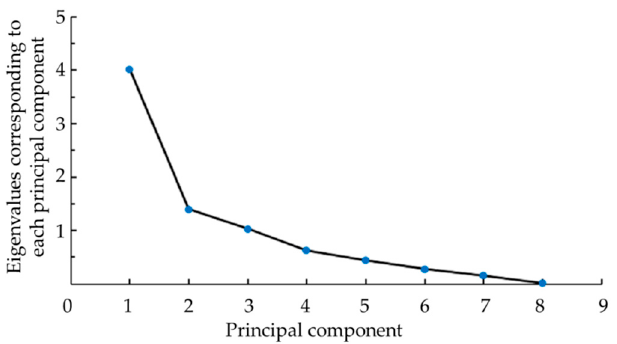
Figure 1. Scree plot of principal component analysis: The X axis is the principal component; The Y axis is the eigenvalues corresponding to each principal component—the amount of each principal component contributed. Generally, the principal component with characteristic value greater than one is selected for evaluation.